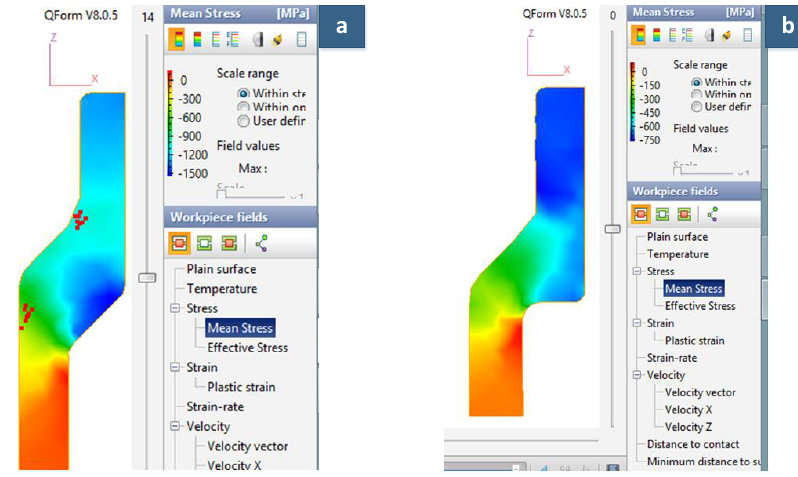
Figure 6. Mean stress distributions in the z -direction with ( a ) one-step stamping and ( b ) two-step stamping.